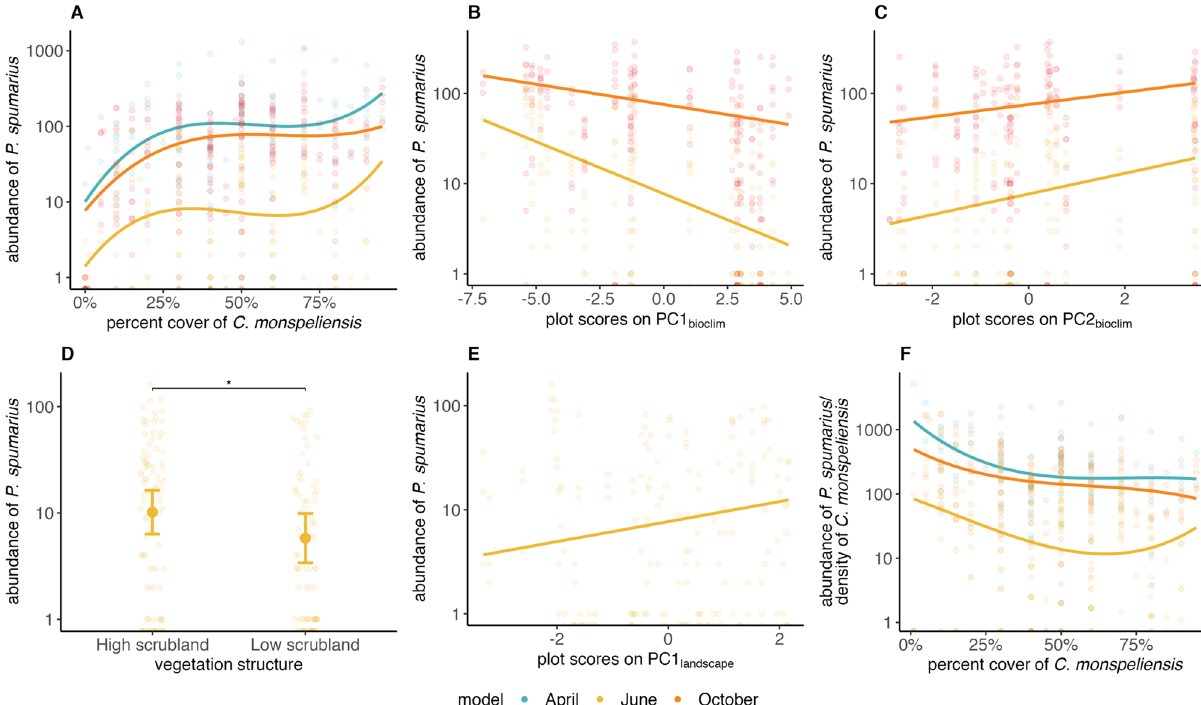
Figure 5. Scatterplots of raw data, regression lines and model prediction for pairwise associations between P. spumarius ( Ps ) abundance and fixed effects (GLMM1: panels ( A ) to ( E ), GLMM2: panel ( F )). ( A ) Ps abundance and percent cover of Cistus monspeliensis . ( B ) Ps abundance and plot scores on PC1 bioclim (which rises with increasing temperature and decreasing precipitation). ( C ) Ps abundance and plot scores on PC2 bioclim (which rises with decreasing climate seasonality). ( D ) Ps abundance as a function of vegetation structure observed in the plot: high scrubland (tree cover exceeding 25%); low scrubland (shrub and herbaceous formations with tree cover below 25%). ( E ) Ps abundance and plot scores on PC1 landscape (which opposed landscapes with tree cover above 25% (high scrublands) at positive scores to landscapes with open areas and tree cover below 25% (low scrubland) at negative scores). ( F ) Ps abundance per host plant and percent cover of C. monspeliensis . Colors: sampling month. Error bars on scatterplots: 95% confidence intervals. Points: raw data; lines: regression curves from models. All correlations have p-values < 0.005. All details on significance tests and R2 of the regression lines are given in Table